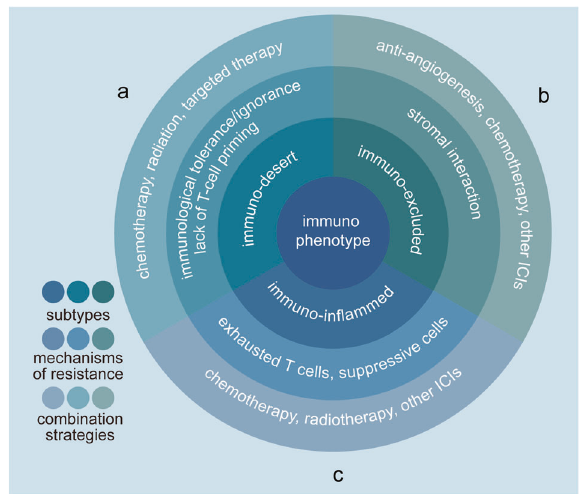
Fig. 3 Potential combination strategies of ICIs in order to overcome resistance based on the immune phenotype. Antitumor immunity can be classi fi ed into three main phenotypes: the immuno-desert tumor ( a ), the immuno-excluded tumor ( b ) and the immuno- in fl amed tumor ( c ). Each of this phenotype is associated with multiple mechanisms of resistance to immunotherapy. In order to overcome resistance to single-agent CPI, combination strategies have been suggested. The most promising ones comprise the combination with another ICIs, cytotoxic chemotherapy, radiation, antiangiogenesis or targeted